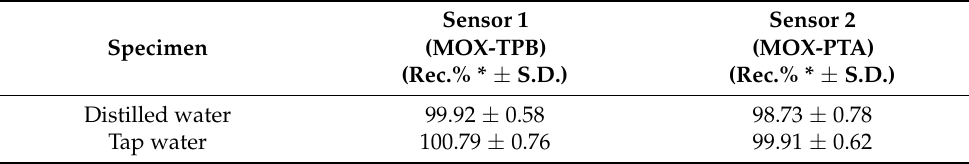
Table 4. Determination of MOX in spiked water samples using the fabricated membrane sensors.